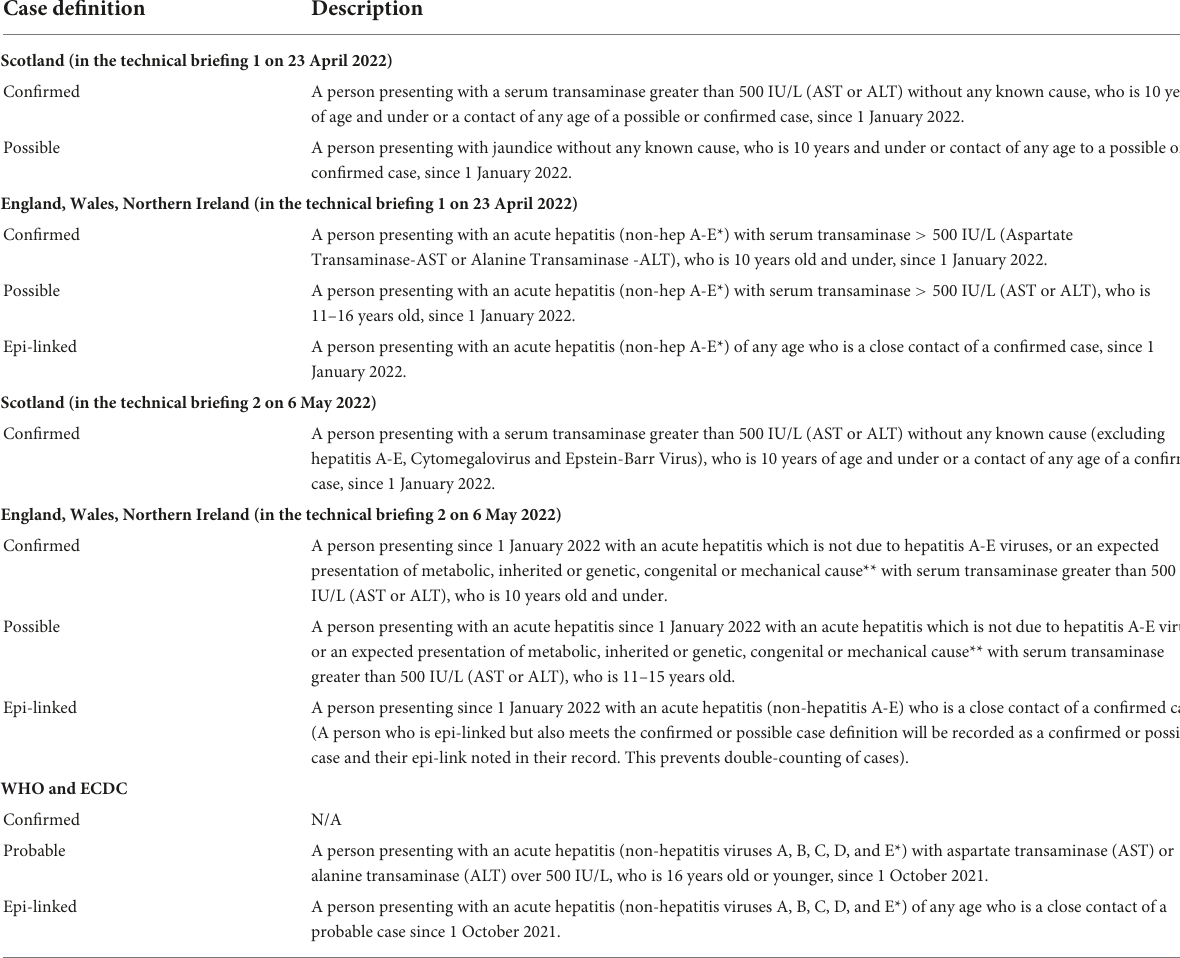
TABLE 1 The definition of acute hepatitis in children of unknown